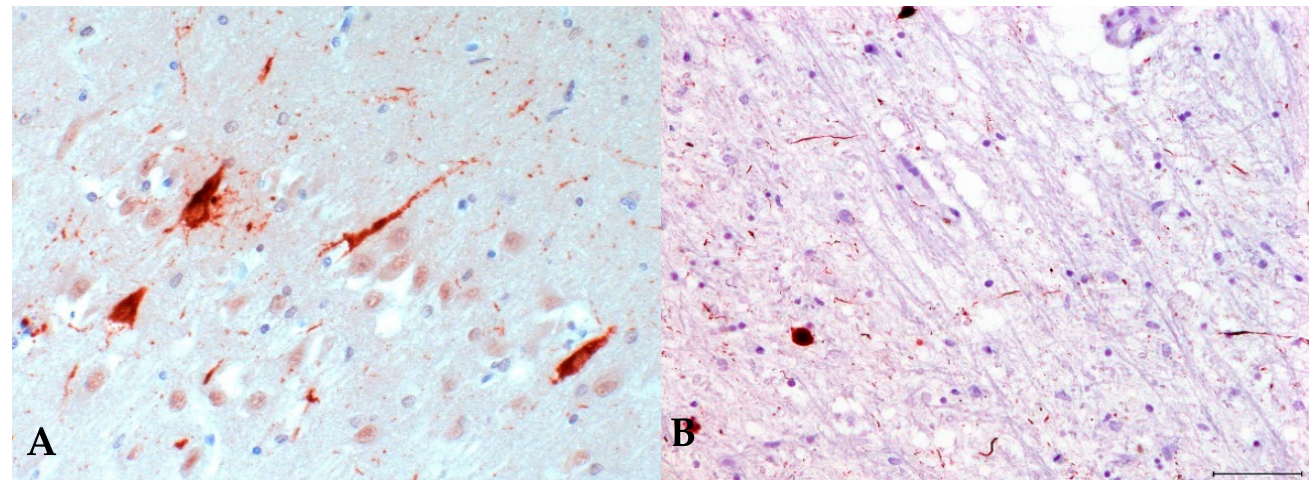
Figure 2. Neuropathology of postencephalitic parkinsonism. ( A ) Hyperphosphorylated tau is demonstrated as flame- shaped intraneuronal neurofibrillary tangles and also seen in the neuropil. Immunoperoxidase stain with hematoxylin counterstain. Midbrain, 200-fold magnification. ( B ) Hyperphosphorylated tau in globose neurofibrillary tangles and in neuropil threads. Immunoperoxidase stain with hematoxylin counterstain. Midbrain, 100-fold magnification.